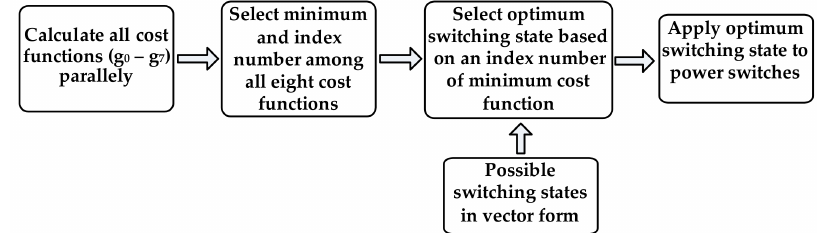
Figure 6. Block diagram for selection of optimum switching state.